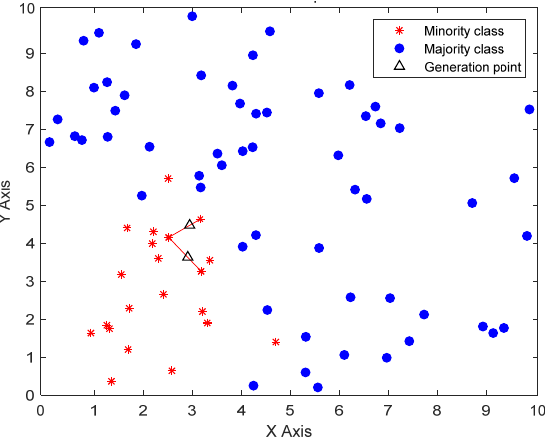
Figure 2. Illustration of SMOTE algorithm. The blue balls, red asterisks, and black triangles, respec- tively represent the majority classes, the minority classes, and the generation points.